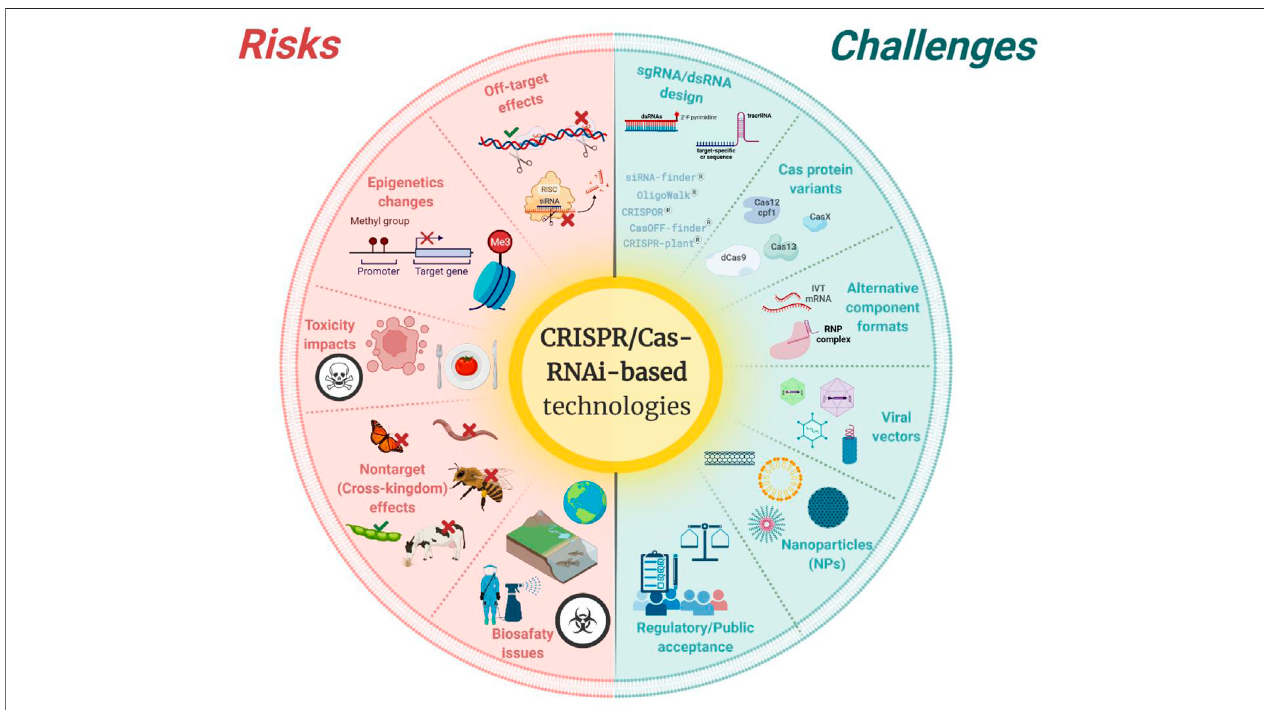
FIGURE1| Summaryofthemain risks(ontheleft — inredcolor)and challenges(ontheright — ingreen color)addressedinthetextand related totheapplication of Clustered regularly interspaced short palindromic repeats (CRISPR)/CRISPR-associated gene (Cas)- and RNA interference (RNAi)-based technologies in agriculture. Created with Biorender software at